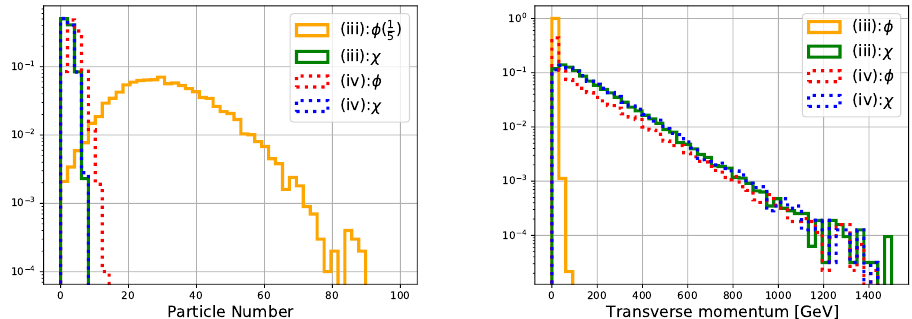
Figure 8 . The multiplicities (left panel) and p T spectra (right panel) of the singlet scalar φ and the singlino χ in the Higgsino production and decay process for benchmark point ( iii ) and ( iv ). The lightest Higgsino mass is taken to be 350